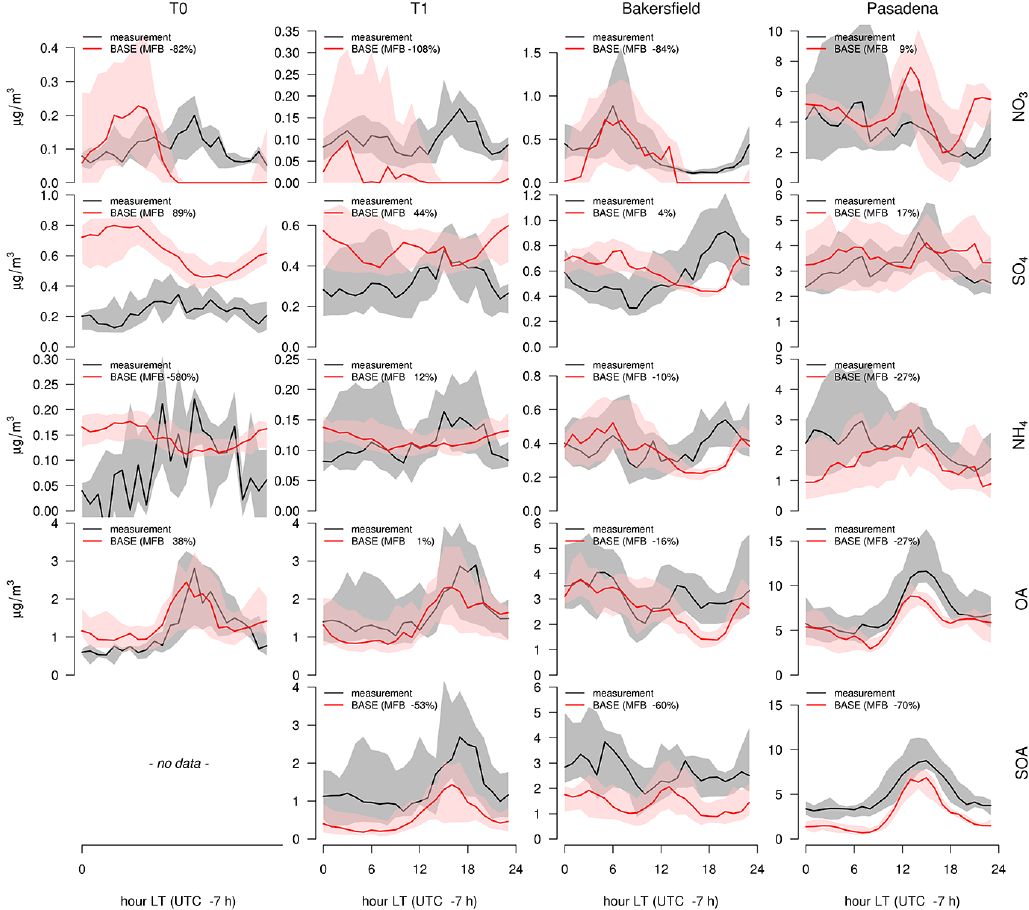
Figure 5. Averaged (29 May 00:00UTC–16 June 00:00UTC) diurnal cycles of model results (BASE, red) against aerosol mass spectrometer (AMS) measurements (black) at the four supersites for nitrate, sulfate, ammonium and organic sub-micron non-refractory aerosol mass. Lowest row shows comparison of modeled SOA against the sum of positive matrix factorization (PMF) factors MO-OOA plus LO-OOA (more and less oxidized oxygenated organic aerosol) at T1, and LVOOA plus SVOOA (low volatility and semivolatile oxygenated organic aerosol) at Bakersfield and Pasadena (see text for details). MFB indicates mean fractional bias against